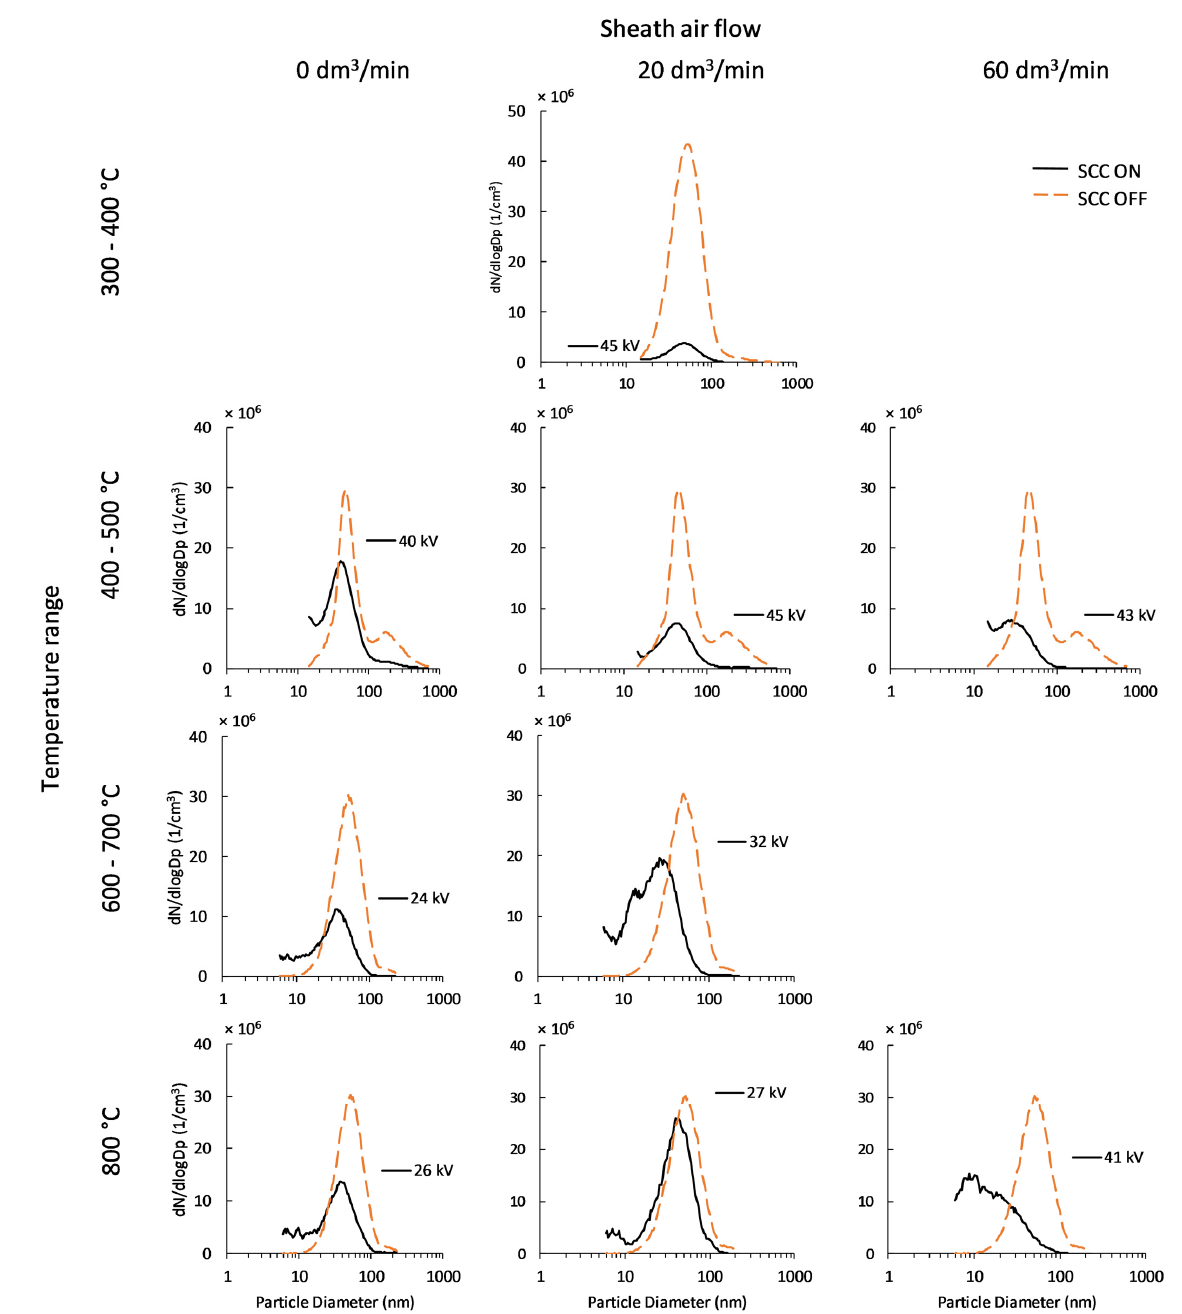
Figure 7. Particle number size distributions measured by scanning mobility particle sizer (SMPS) in different scenarios of sheath air through the shielded corona charger (SCC) and surrounding temperature at the SCC’s location inside the reactor.